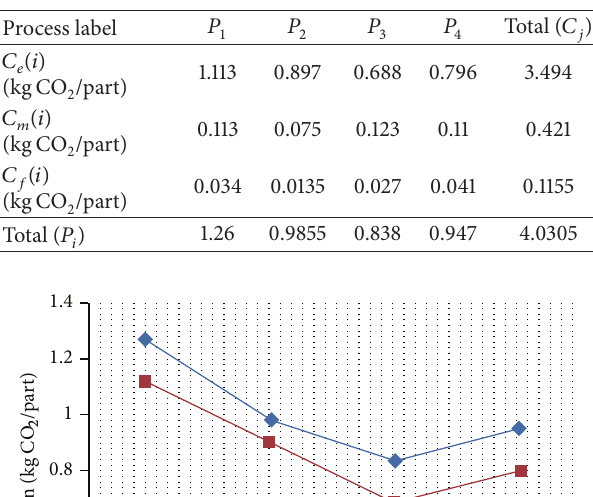
Table 4: The total carbon emissions of each unit process.